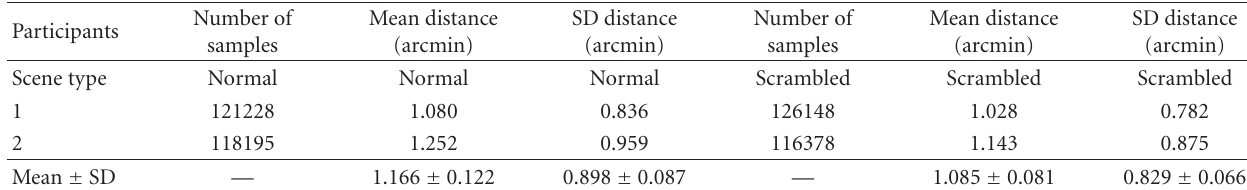
Table 3: Results of Experiments 2 for each participant and for the